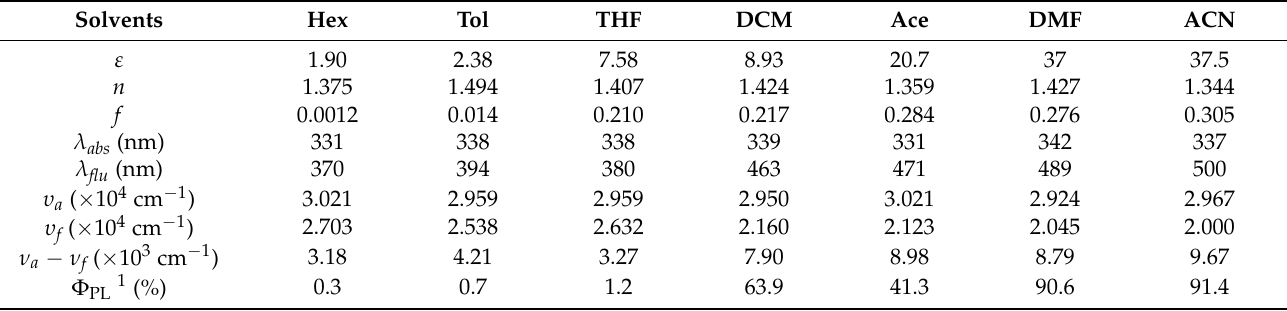
Table 1. Detailed photophysical data of BP-3-Cz in different